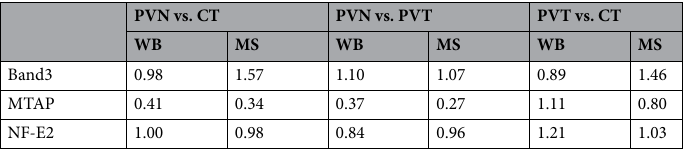
Table 3. Relative abundances (log 2 of fold change) of Band 3, MTAP and NF-E2 from quantitated western blot band intensities (normalised with β-globin) and MS